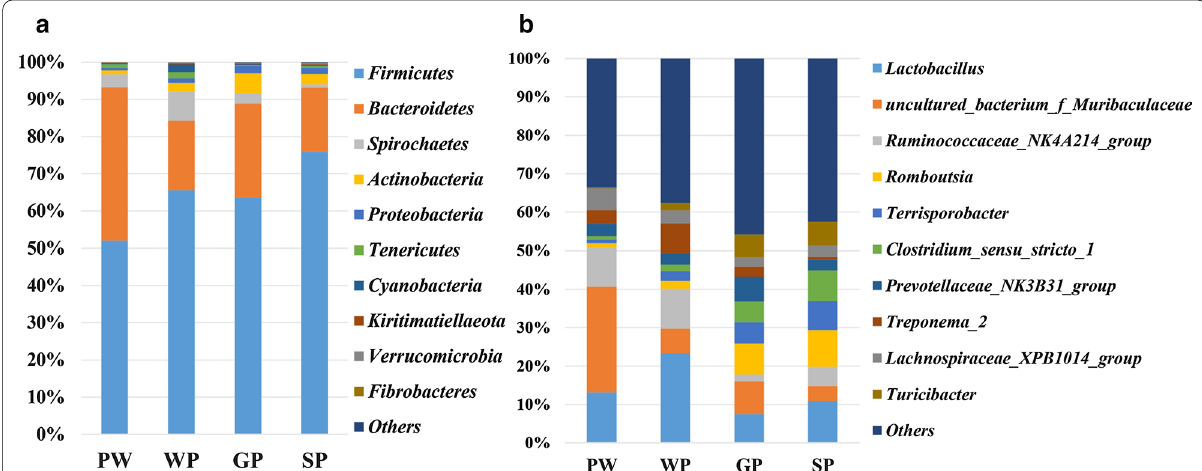
Fig. 1 Histogram of the top 10 phylum ( A ) and genus ( B ) in each